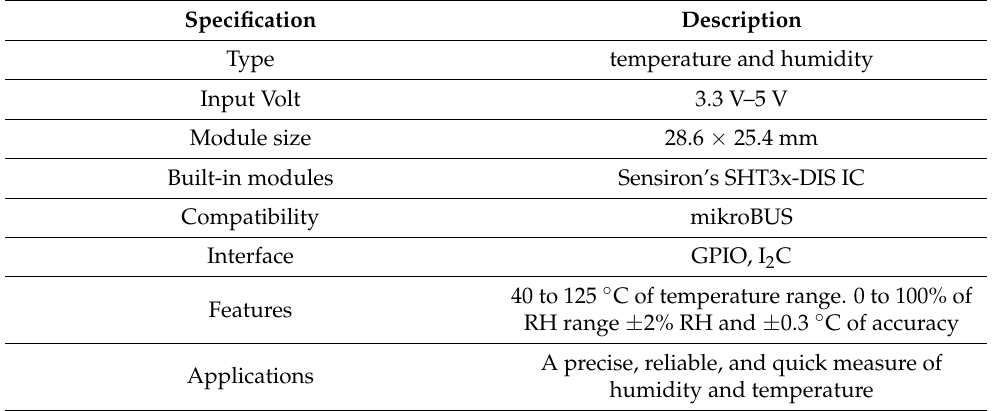
Figure 8. SHT click sensor module. Table 8. SHT click sensor module specification. Adapted from ref. [32].